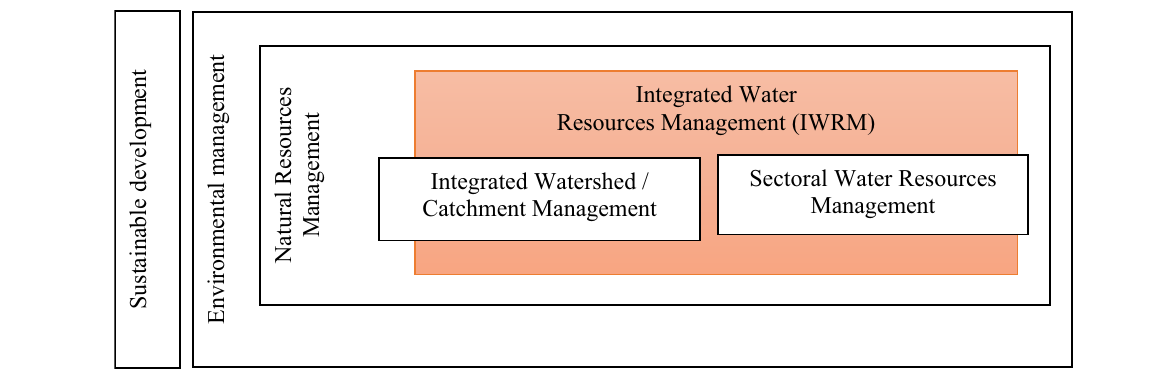
Fig. 2 Integrated water resources management and sustainable development (After Jouravlev and Chávez